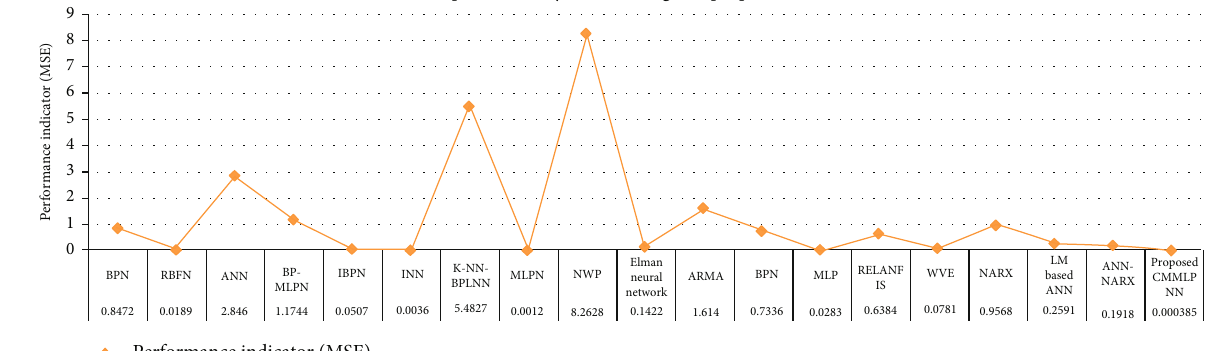
Figure 23: Comparative analysis of existing and proposed